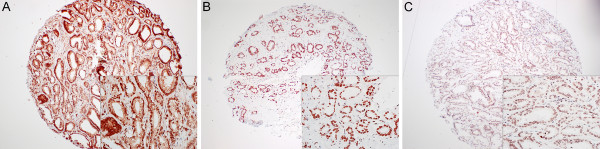
Representative staining of H4K20me1 (A), H4K20me2 (B) and, H4K20me3 (C) in prostate cancer tissue; all antibodies are showing nuclear staining (magnification ×10; in-box figure magnified ×20).